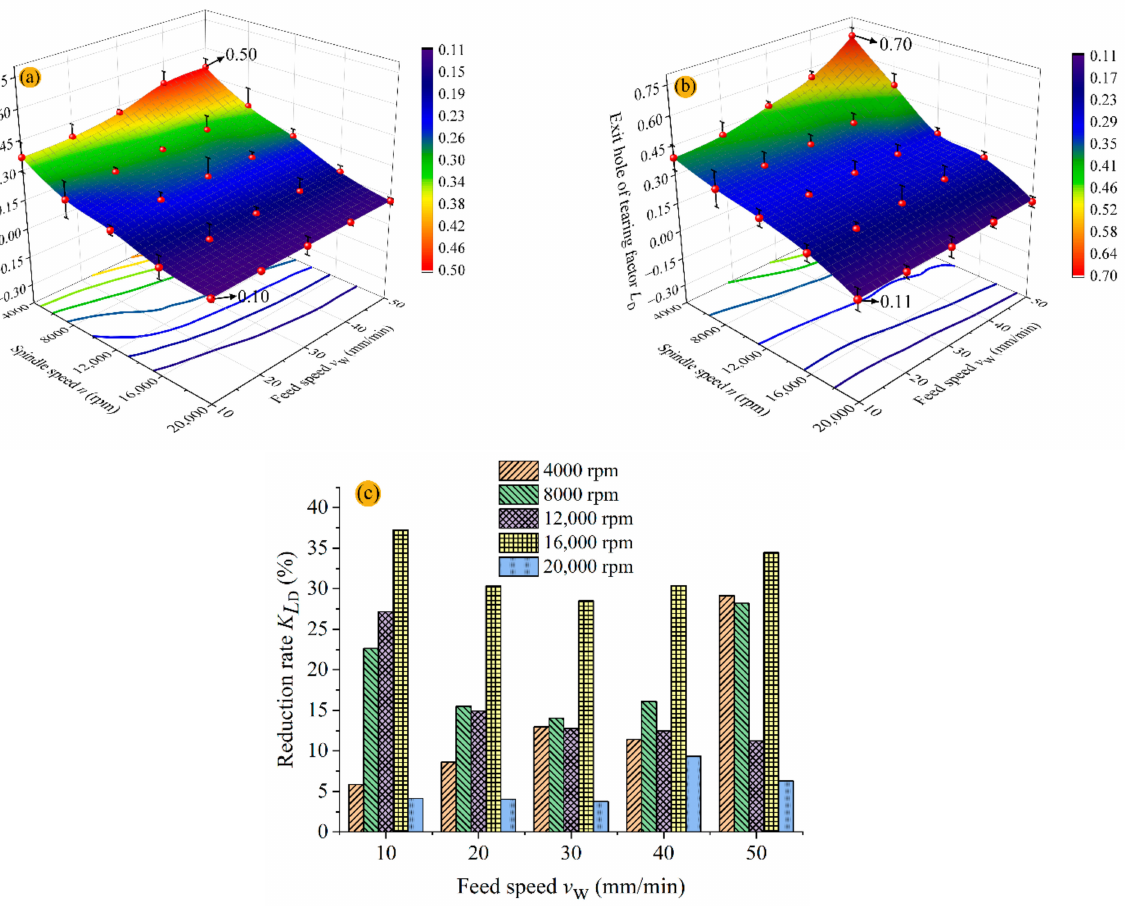
Figure 14. Effect of different parameters on exit tearing factor and its reduction, ( a ) variation trend of exit hole of tearing factor in RUAD, ( b ) variation trend of exit hole of tearing factor in CD, and ( c ) reduction